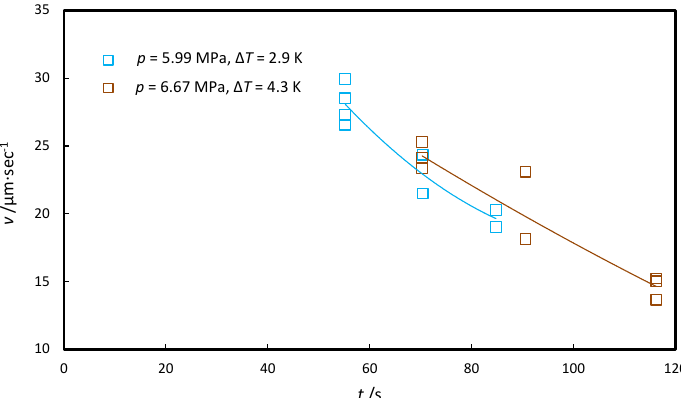
Figure 17. Methane hydrate film velocity versus time for the system water + MEG ( w MEG = 10%) + CH 4 at uniform surface temperature. Continuous lines are drawn to increase the readability of the graph, but do not represent a modeling